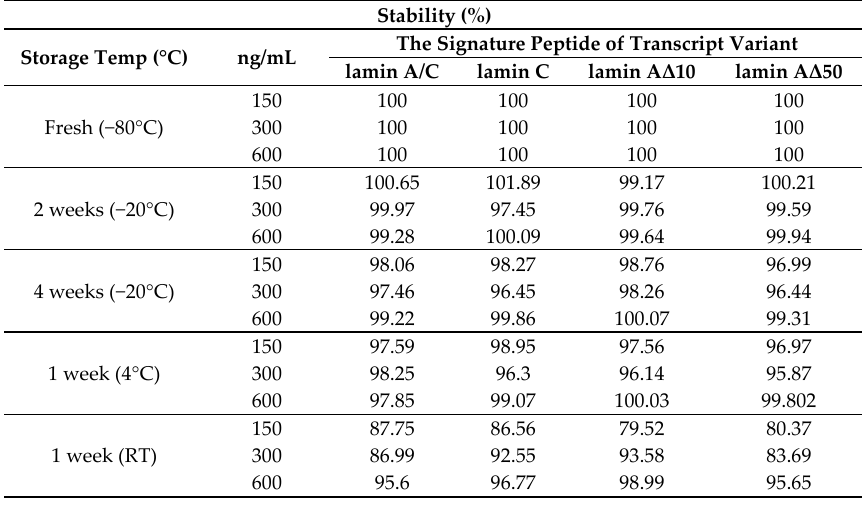
Table 5. Stability of peptides in extracted samples ( n = 9).